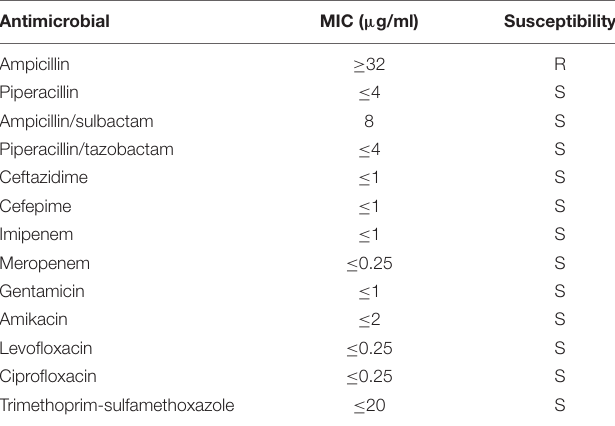
TABLE 2 | Antimicrobial susceptibility results of the Vibrio alginolyticus strain. Antimicrobial MIC ( µ